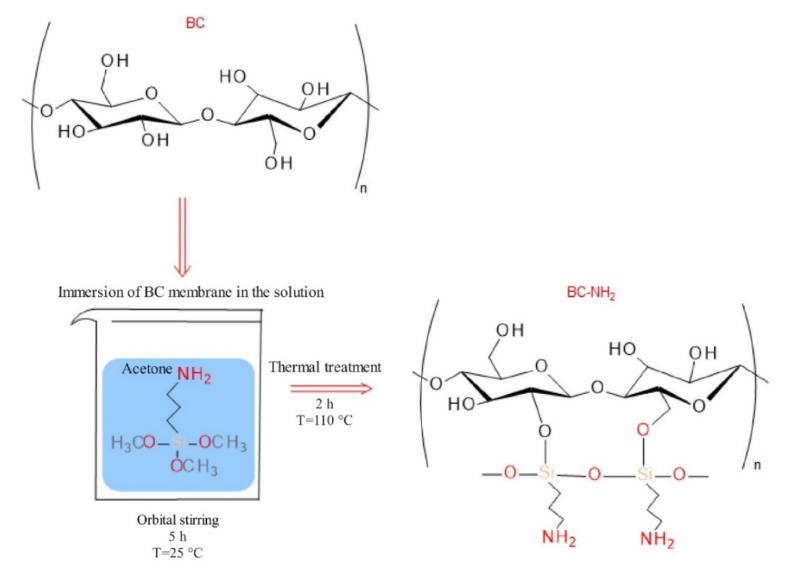
Figure 9. General procedure for bacterial cellulose silane chemical grafting with APS (summarized by